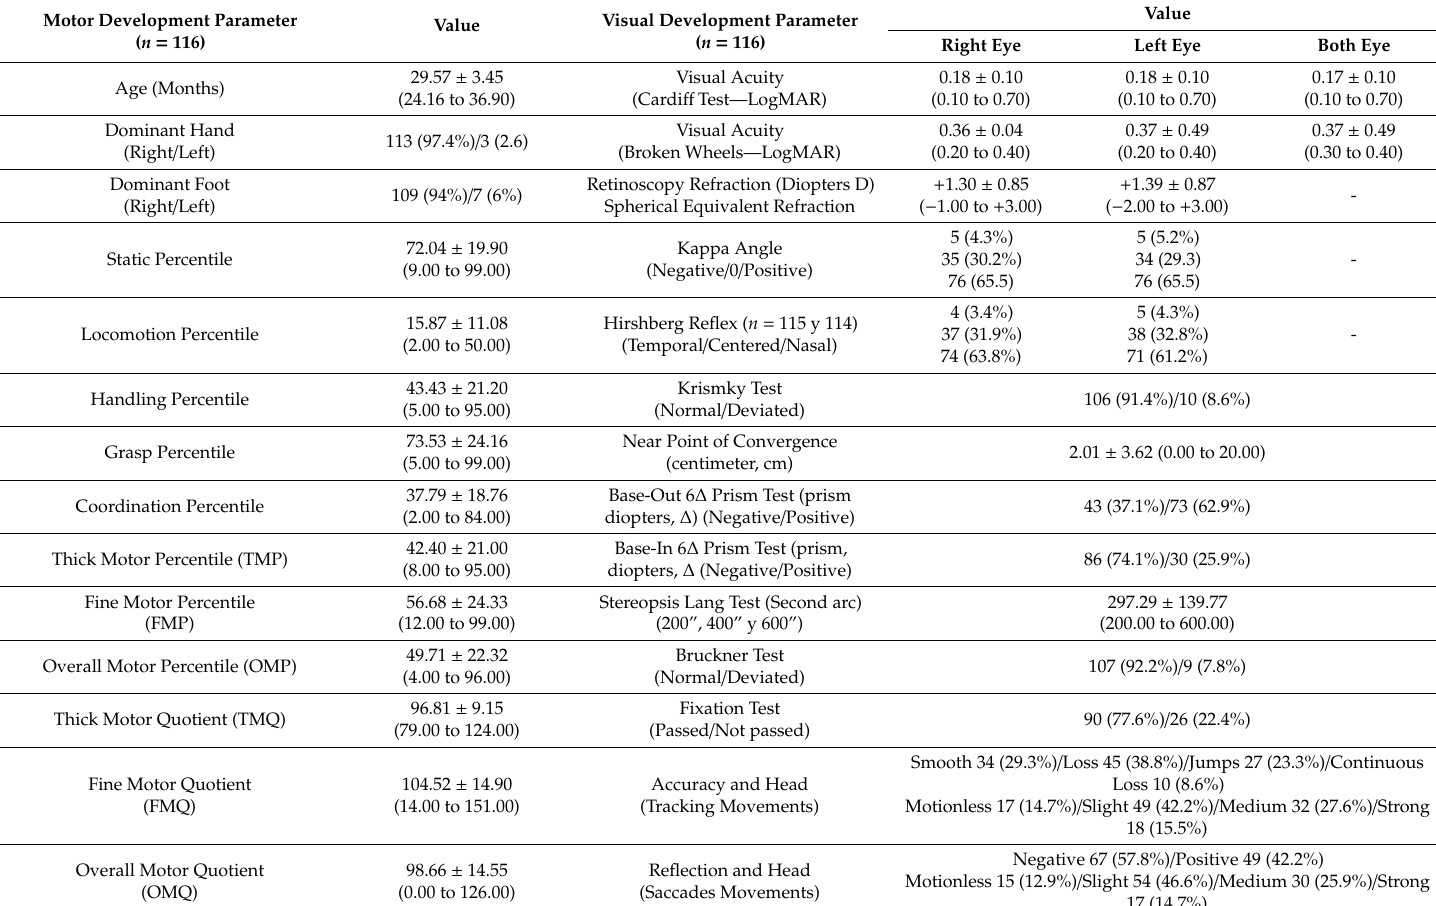
Table 1. Population characteristics for motor and visual